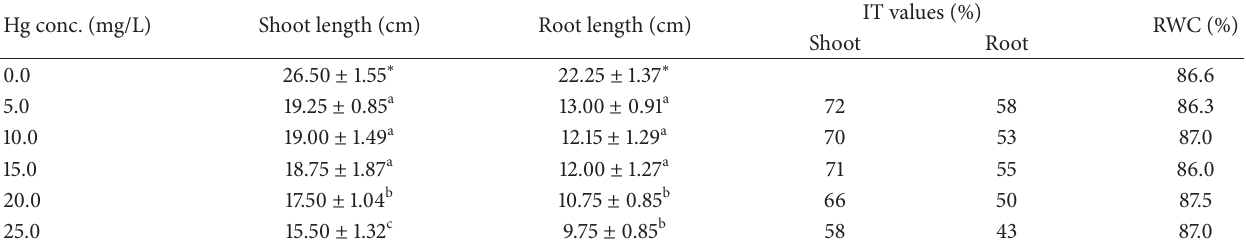
Table 1: Effect of mercury heavy metal exposure on seedlings growth, biomass, and relative water content of M. arvensis . Hg conc. (mg/L)